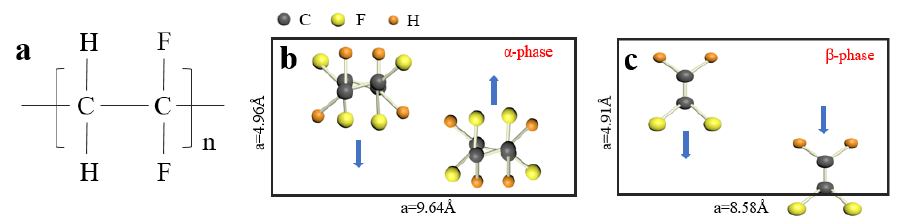
Figure 1. ( a ) Molecular structure of PVDF; ( b ) unit cell structure of non-ferroelectric α -phase PVDF; ( c ) unit cell structure of ferroelectric β -PVDF (the arrows indicate the dipole moments in the unit).